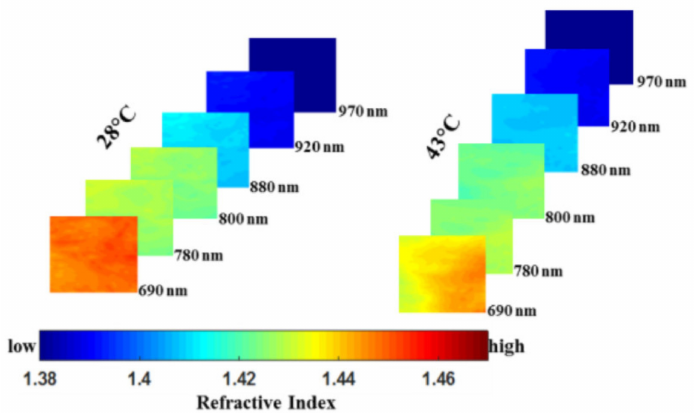
Figure 6. A series of 2-D false-color spatial maps of the refractive index (RI) at different wavelengths for two extreme temperatures of 28 ◦ C and 43 ◦ C (adapted from Ref.